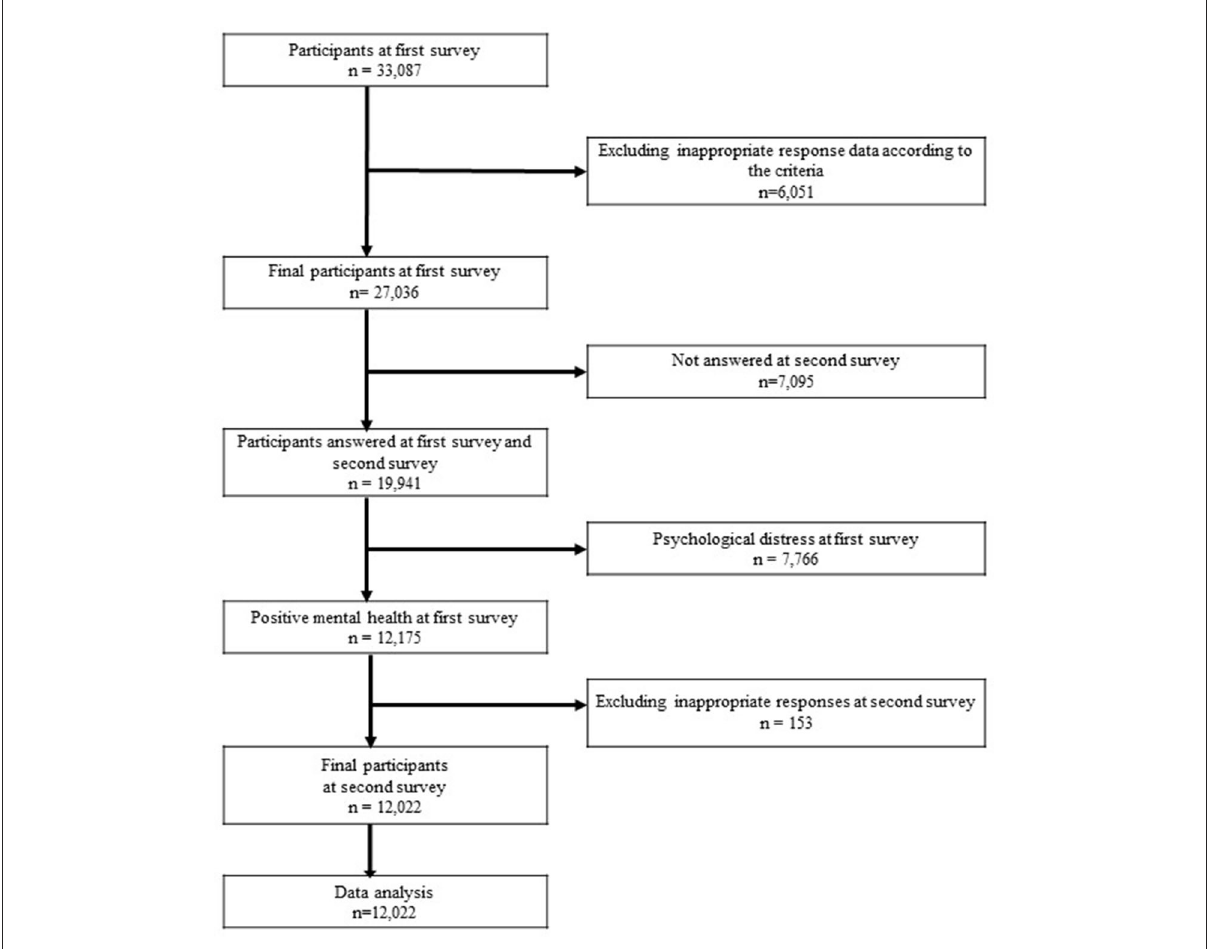
FIGURE1 Flow diagram of the